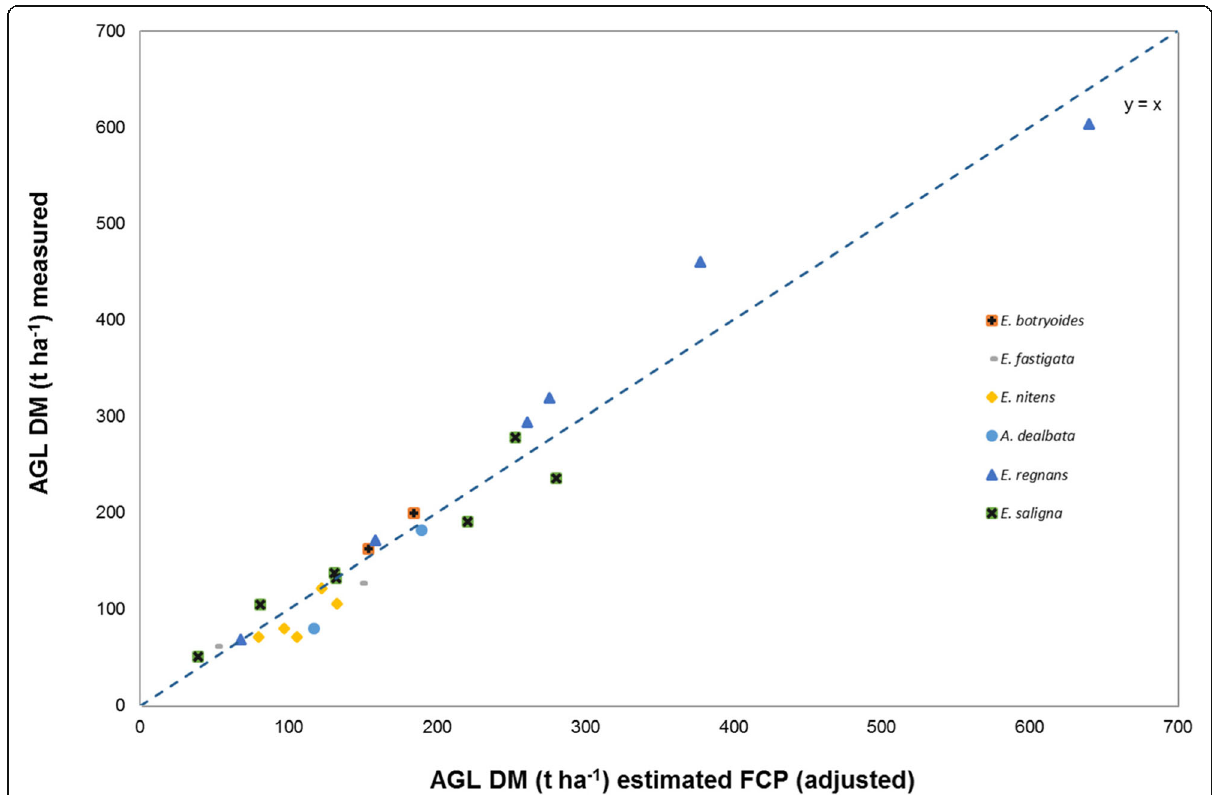
Fig. 4 Relationship between measured aboveground live dry matter (AGL DM) in Eucalyptus/Acacia spp. stands and adjusted predictions from the Forest Carbon Predictor